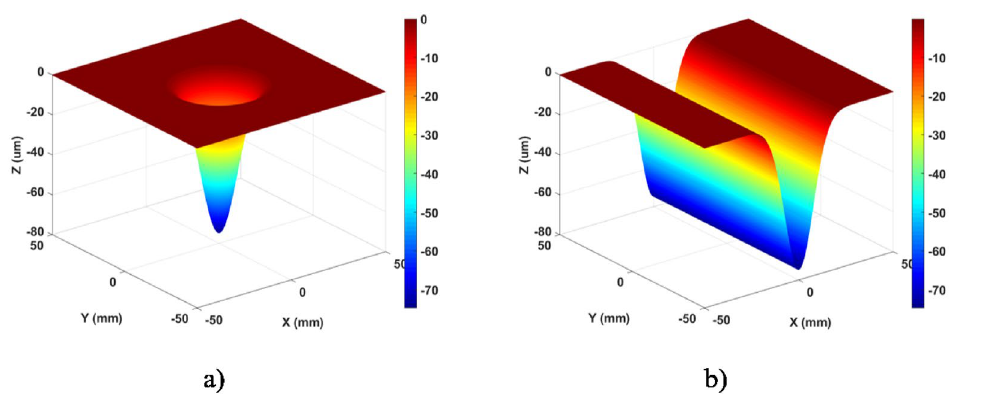
Figure 6. Schematic of ( a ) static removal function and ( b ) scanning removal function